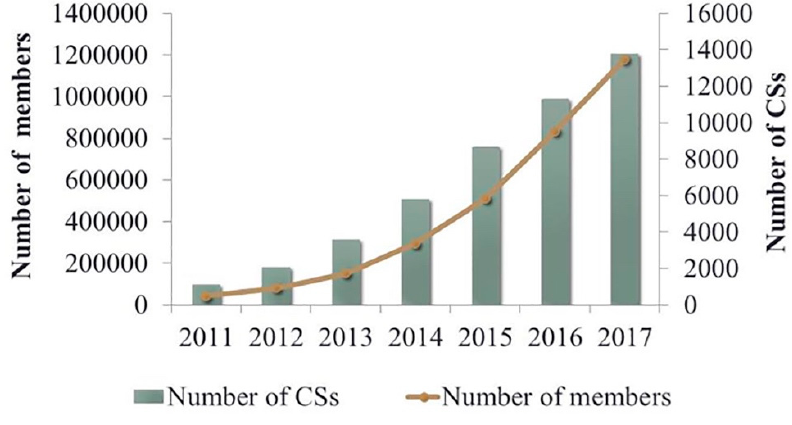
Figure 1. The number of CSs and their members (coworkers) worldwide (2011–2017). Source: own elaboration based on data from: 2017 Global CoWorking Survey, www.deskmag.com.